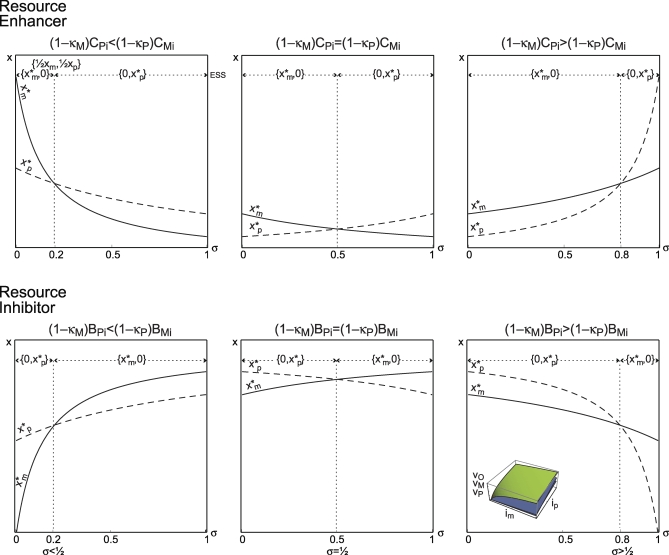
ESS Pattern of ExpressionThe horizontal axis represents the fraction of resources contributed by the mother σ. The vertical axis represents the total level of expression of an RE (top row) and an RI (bottom row). The continuous line corresponds to the optimal level of expression from the perspective of the maternally inherited allele
as a function of the fraction of resources contributed by mothers σ. The discontinuous line corresponds to the optimal level of expression from the perspective of the paternally inherited allele
as a function of the fraction of resources contributed by mothers σ. The intersection of both these lines corresponds to the value σ in which the conflict becomes extinct,
σ̂. In the top part of each figure, the evolutionary stable pattern of expression
is represented. If (1−κM)CPi < (1−κP)CMi (first column) the conflict becomes extinct when mothers contribute less resources than fathers, σ < ½. If (1−κM)CPi = (1−κP)CMi (second column) the conflict becomes extinct when mothers contribute as many resources as fathers, σ = ½. If (1−κM)CPi > (1−κP)CMi (third column) the conflict becomes extinct when mothers contribute more resources than fathers, σ > ½. The figure inserted at the bottom right corner represents the offspring fitness function vO (in green) and the parental fitness functions (maternal vM and paternal vP) (in gray) used to elaborate the figure, where vo = log(1 + iM + iP), vM = zMiM + κMzPiP, and vP = κP zM iM + zPiP) where zM and zP are constants.